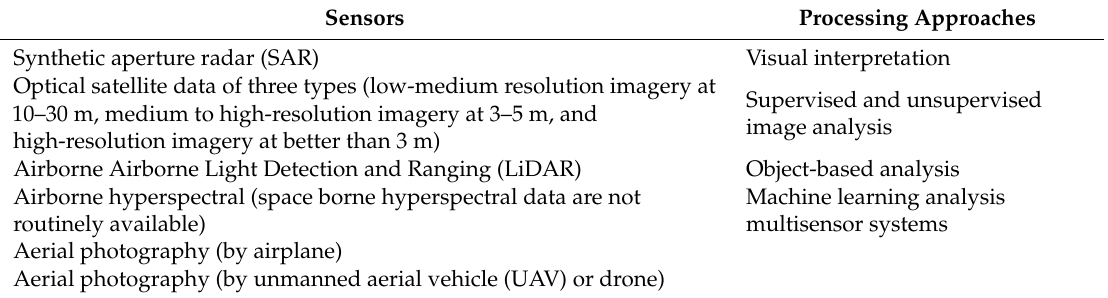
Table 2. A list of the remote sensing sensors and processing approaches assessed in this review. Sensors Processing Approaches